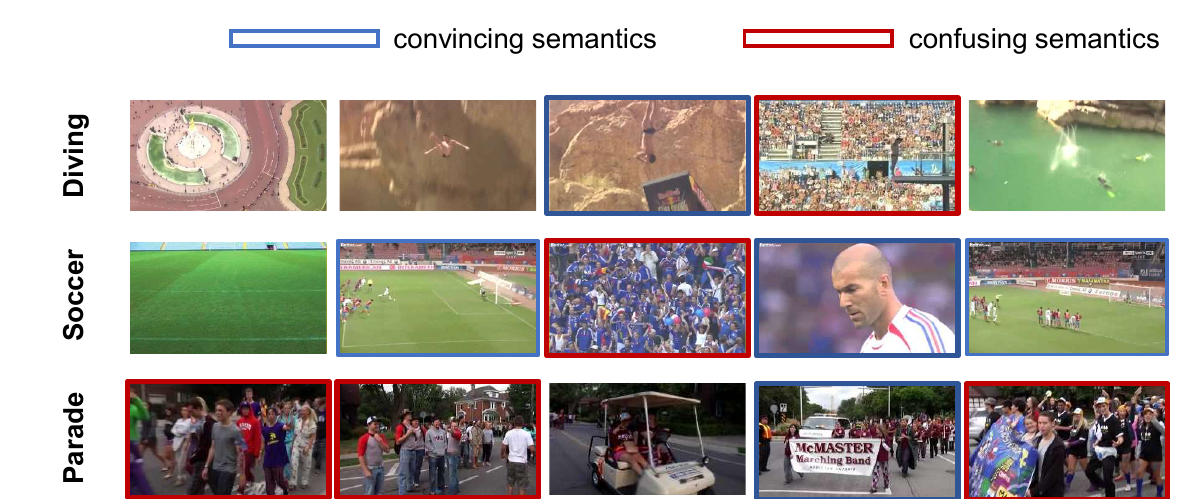
Figure 1. Given different videos, a variety of long-term video semantics can be found in the videos. This figure shows video semantics in the “Diving”, “Soccer”, and “Parade” videos. Watching these video semantics together, we obtain some interesting findings. It seems that he “crowd” semantics in the red boxes are confusing. They appear in all the videos and are little help in terms of distinguishing the videos. However, the video semantics in the blue boxes can convincingly help us distinguish the videos. For example, the “penalty kick” clip in the second row almost implies that this is a “soccer” video. Based on the above, in this paper, we pay more attention to discriminating the confusing and convincing video semantics and utilize them for generating our compact video representation. To achieve this goal, we propose a novel continuous video semantic embedding model integrated with a well-designed discriminative negative sampling